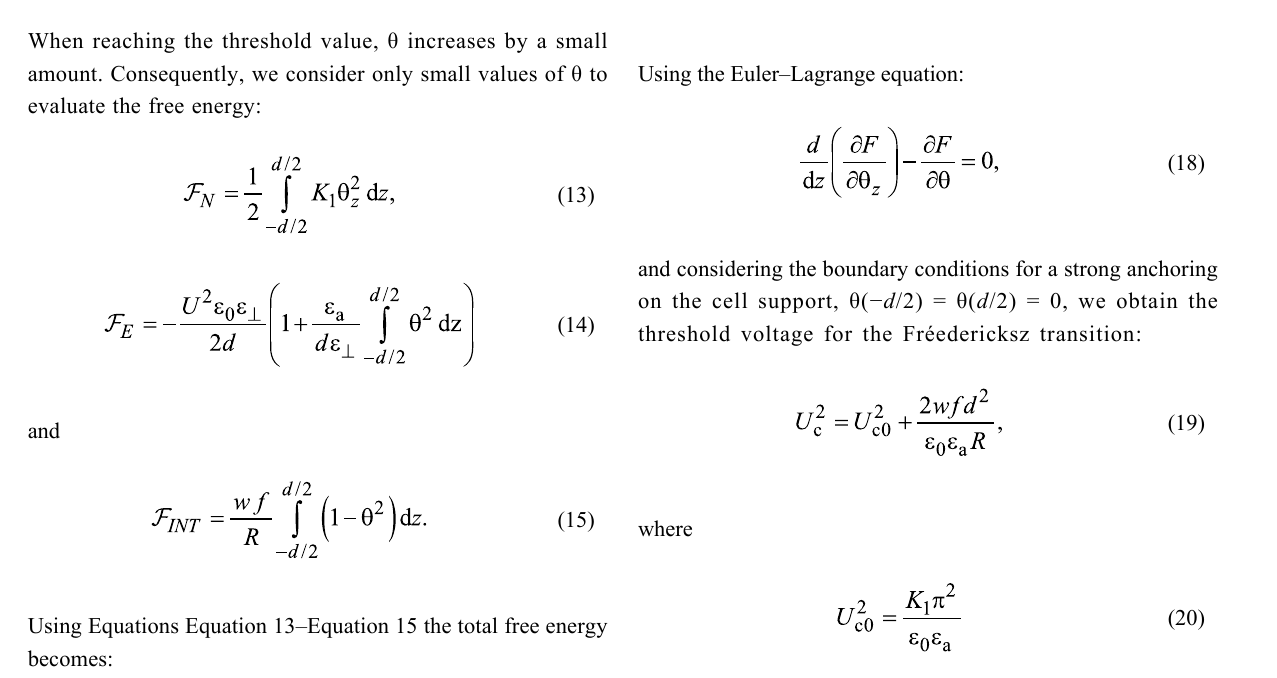
(at least 1 hour) the nanotubes align parallel to the field, due to their positive anisotropy [18-21]. When the field is then switched off, the LC molecules return to their original position, but their movement is slowed by the same anchoring forces acting on the nanotube surfaces (Figure 4c). In this case, a longer relaxation time is